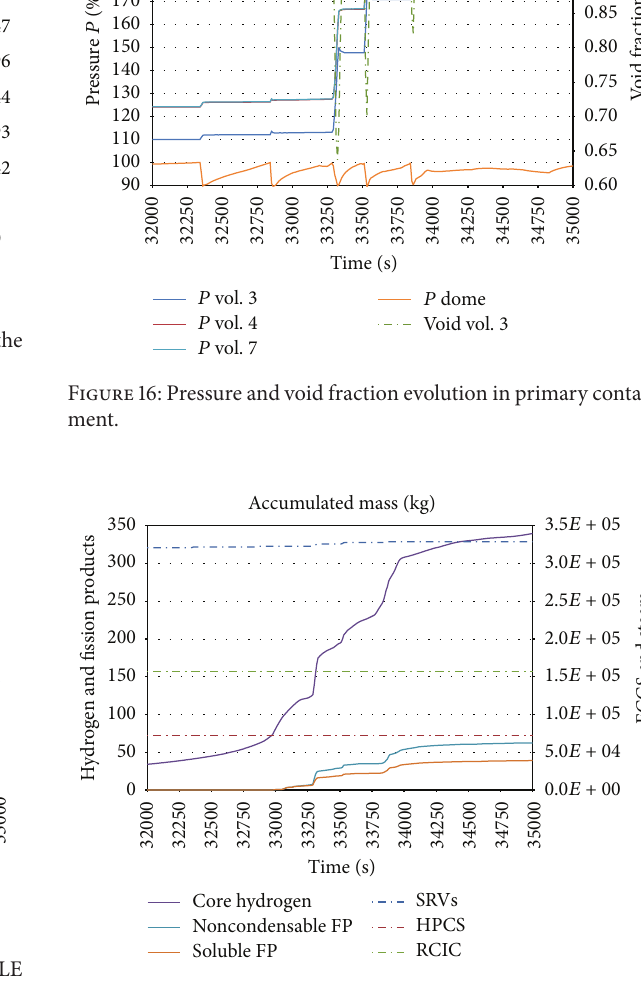
Figure 17: Total accumulated mass of hydrogen generated in core, fission products released, emergency cooling injected in vessel, and steam discharged to the